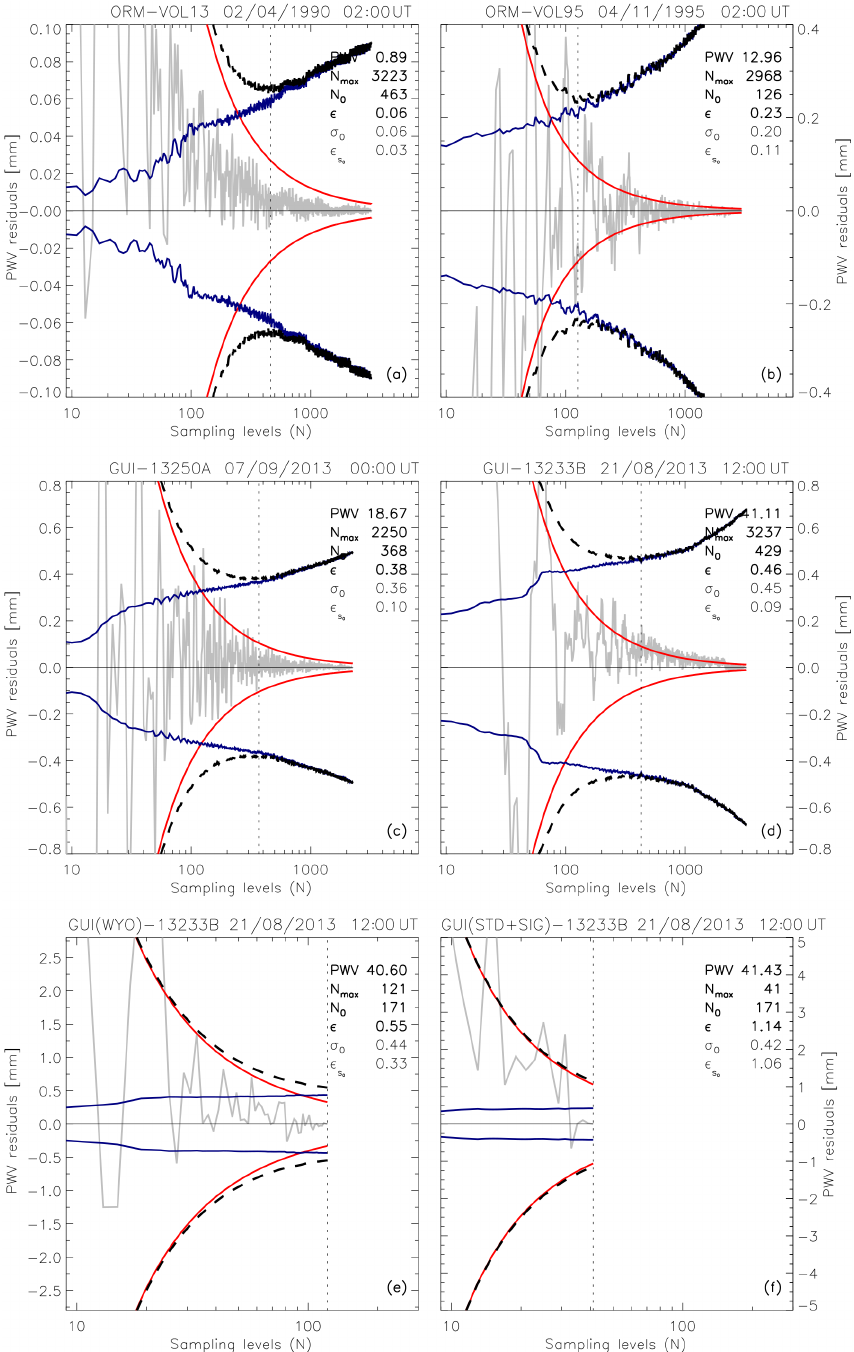
Figure 5. Six graphic examples with the application of the method of sub-sampling error optimization for ORM (a) and (b) and GUI (c) and (d) , with different PWV concentrations and N max (cid:29) N 0 . Panels (e) and (f) show the same profile as (d) but from data from the WYO repository (see Sect. 1.1), where N max ≈ N 0 and with the SD + SIG levels ( N max < N 0 ). The solid grey line shows the residual between the sub-sampled PWV estimation and the best value with all the levels available. The vertical dotted lines are the optimized number of samples for the minimum error. The PWV and errors in the legend are in